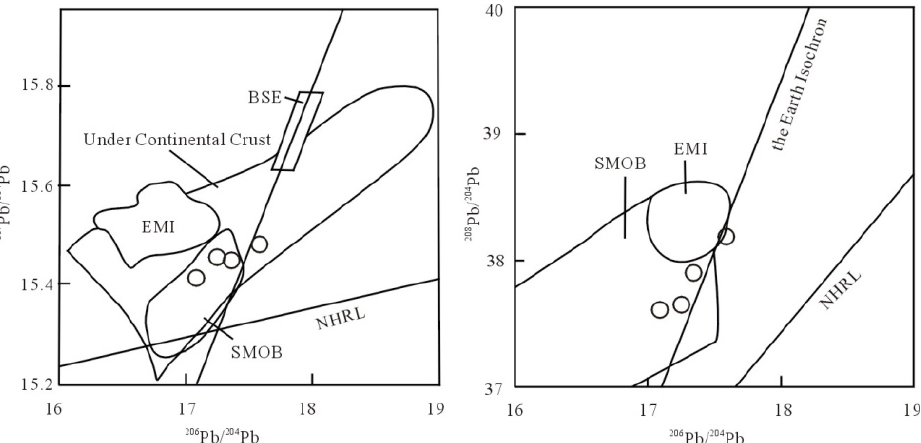
Figure 8. 206 Pb/ 204 Pb versus 207 Pb/ 204 Pb and 208 Pb/ 204 Pb diagram for the Xingdi No.2 mafic-ultramafic rocks. Values typical of various mantle reservoirs are taken from [44]. BSE: Bulk standard earth, SMOB: Sky island in the North Atlantic, Mull island, and ODPLeg 152 basalt, EMI: I-typed enriched mantle, NHRL: Northern hemisphere reference line.